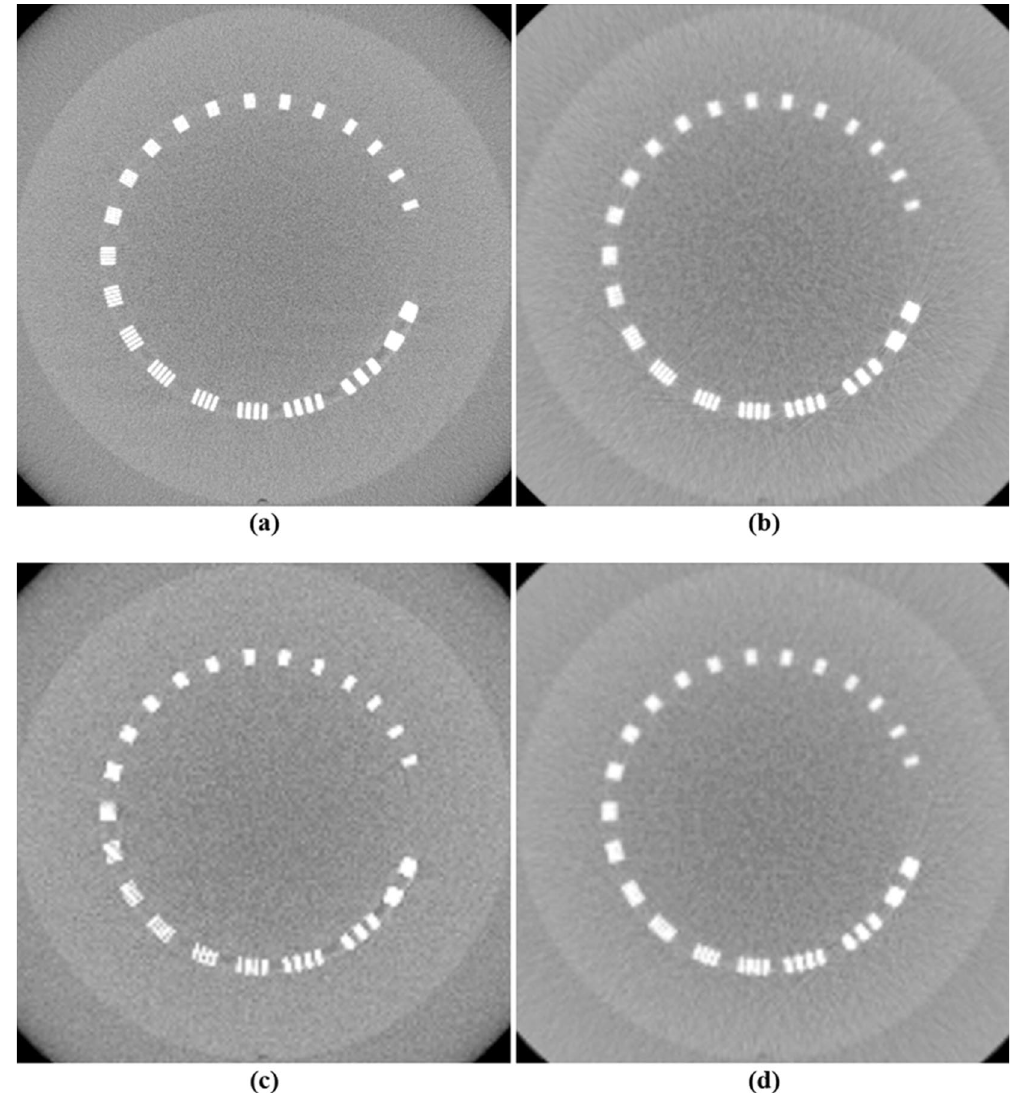
Figure 7. Comparison of a representative slice of the reconstruction image generated by applying FDK using high mAs projections and FDK with NLTV + cubic B-spline interpolation using low mAs projections. ( a ) high resolution benchmark image, ( b ) high resolution CBCT produced by the proposed method, ( c ) low resolution benchmark image, and ( d ) low resolution CBCT produced by the proposed method. These images are displayed at window (width and level) settings of (2000, 0)